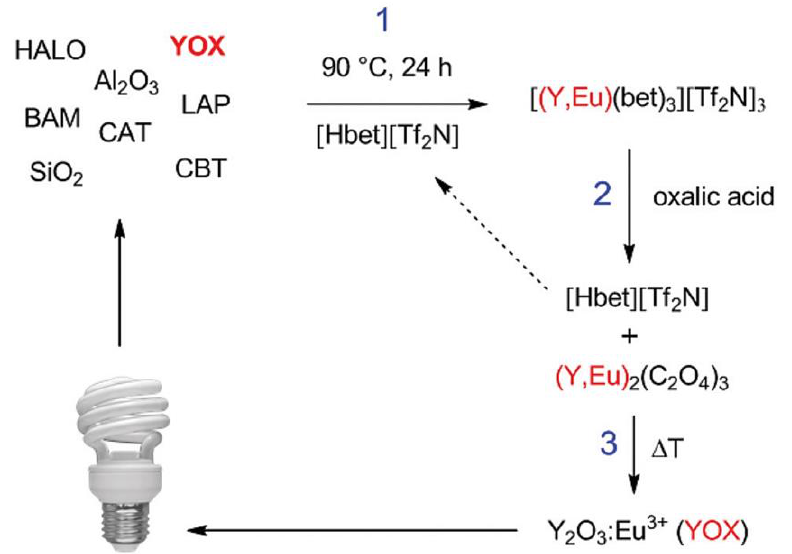
Figure 7. Summary of the suggested recycling process for lamp phosphor wastes. Phase 1: Dissolution of Y 2 O 3 ; Phase 2: Regeneration of ionic liquid (stripping); and Phase 3: Conversion to yttrium(III) oxide. Reproduced from [107] with permission from the Royal Society of Chemistry.